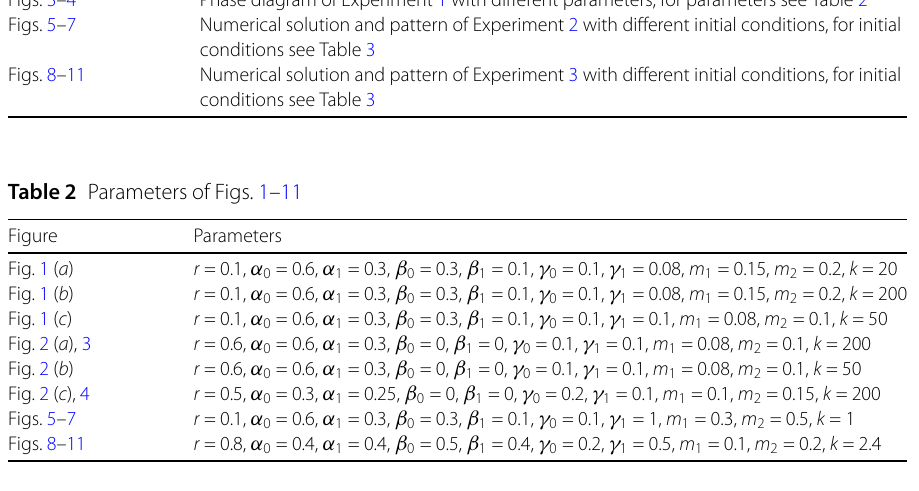
Fig. 8 Fig. 9 Fig. 10 Fig. 11 sin(50 x 2 + 200 y – 9) cos( π (( x – 2